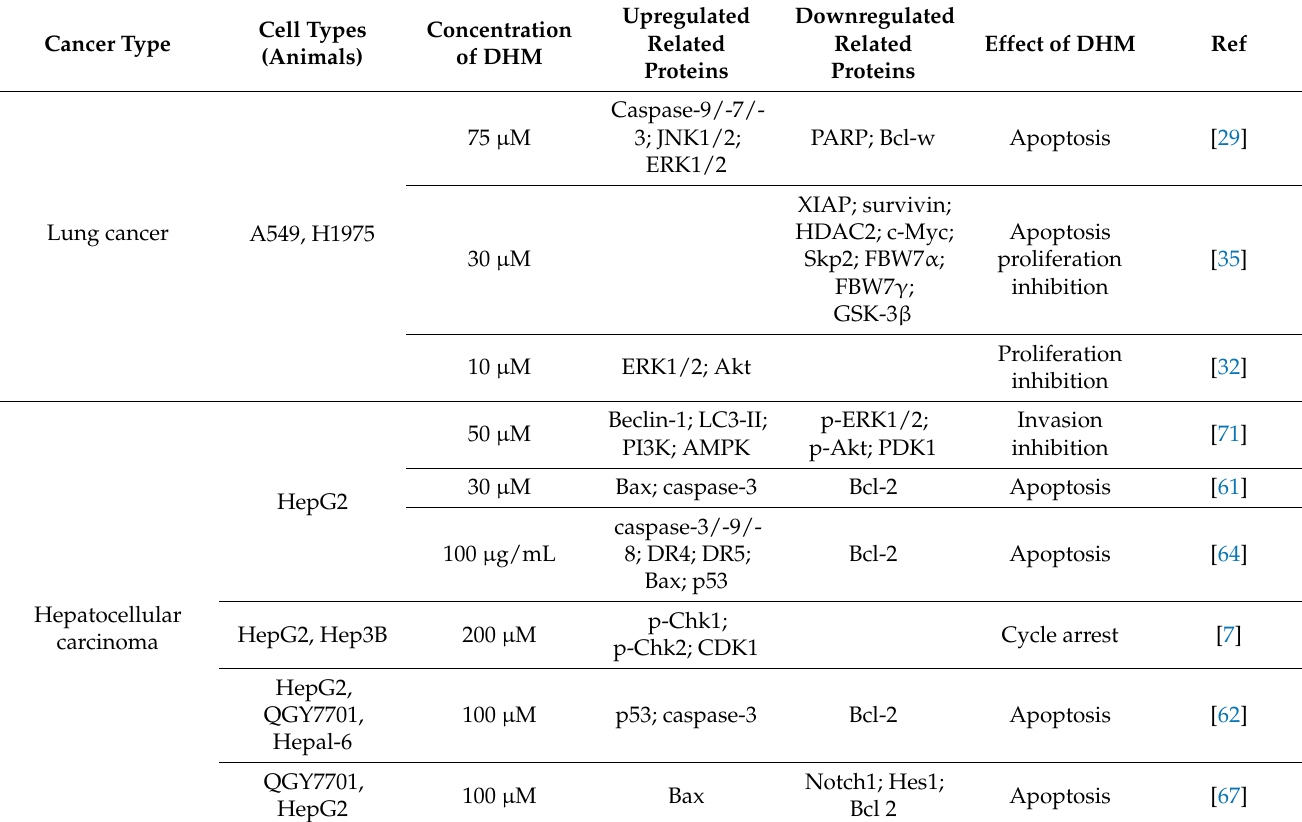
Table 1. Anticancer activities of